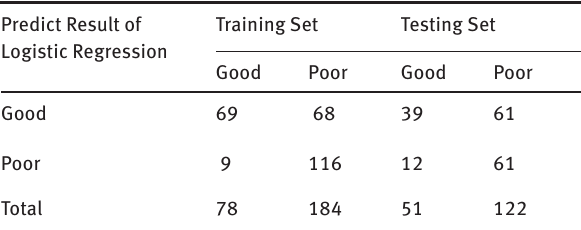
Table 5: Discriminatory Outcomes of BP